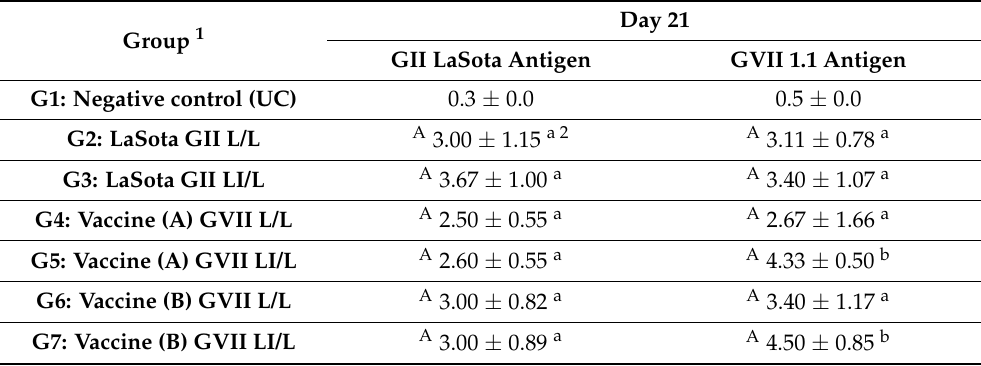
Table 3. Mean log 2 hemagglutination inhibition antibody titers in vaccinated birds using homologous and heterologous antigens at 21 and 31 days of